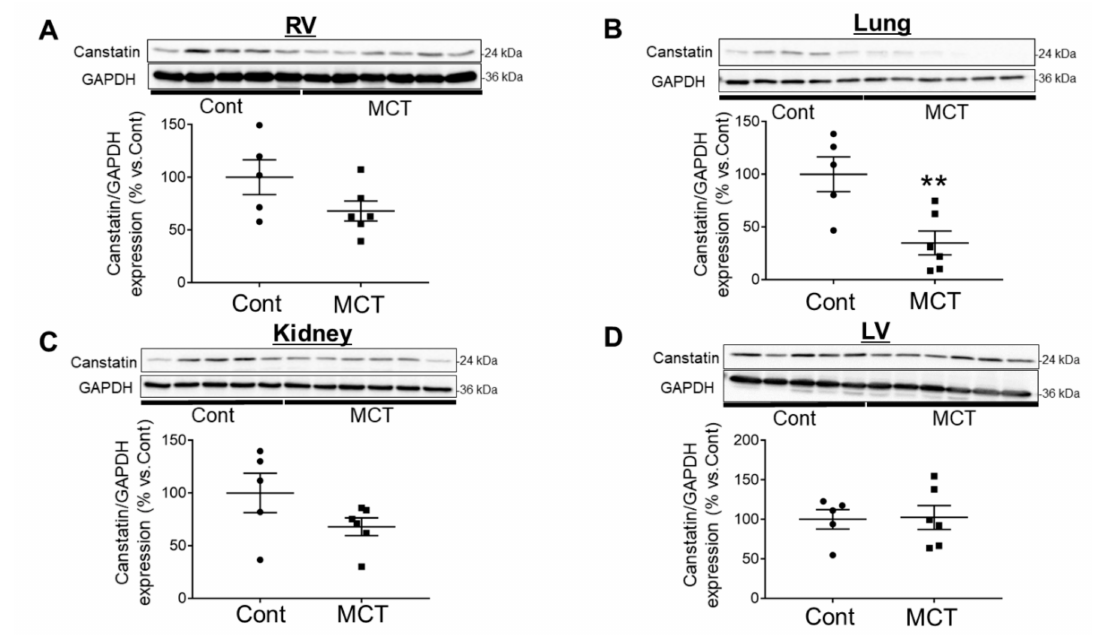
Figure 2. Expression level of canstatin in RV, lung and kidney but not left ventricle (LV) was decreased in a rat model of monocrotaline-induced PAH. Eight-week-old male Wistar rats were intraperitoneally injected with saline (Cont) or monocrotaline (60 mg / kg, MCT). Three weeks later, RV ( A ), lung ( B ), kidney ( C ) and LV ( D ) were isolated and total protein was extracted. The expression of canstatin was measured by Western blotting. (Upper) Representative blots of canstatin and glyceraldehyde 3-phosphate dehydrogenase (GAPDH) are shown. (Lower) Levels of canstatin were corrected by GAPDH, and the normalized expression relative to Cont is shown as mean ± S.E.M. (Cont: n = 5, MCT: n = 6). ** p < 0.01 vs. Cont.